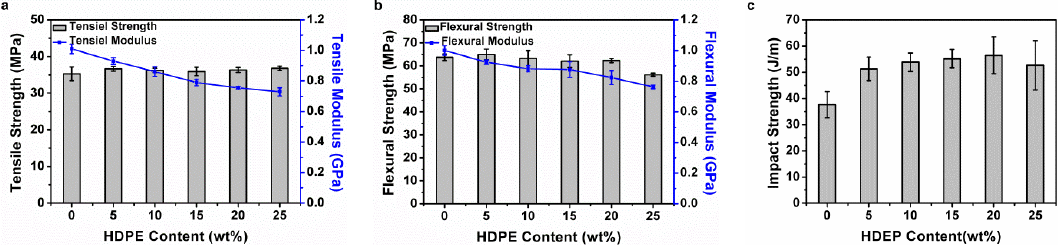
Figure 1. ( a ) Tensile properties, ( b ) flexural properties, and ( c ) impact strength of the polypropylene/high density polyethylene (PP/HDPE) polyblends.